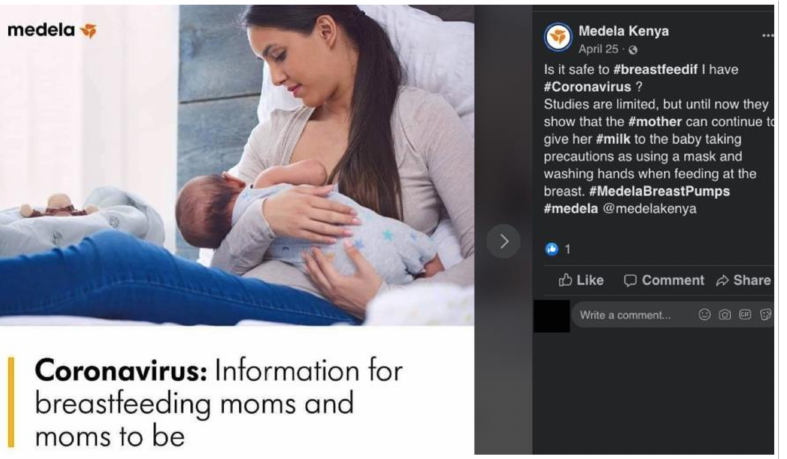
Figure 10. Screenshot of Medela Kenya’s Facebook post on “Coronavirus: Information for breast- feeding moms and moms to be”. The “information” emphasized “giving milk” without directly mentioning “breastfeeding”. Hashtags included